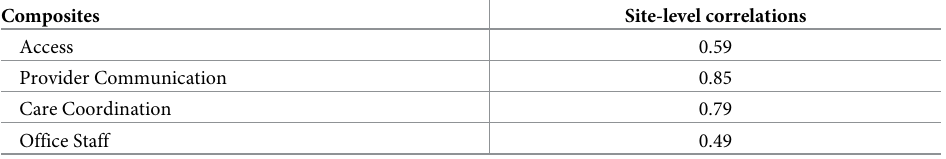
Table 3. Pearson correlation coefficients between Japanese CG-CAHPS composites and overall provider rating.